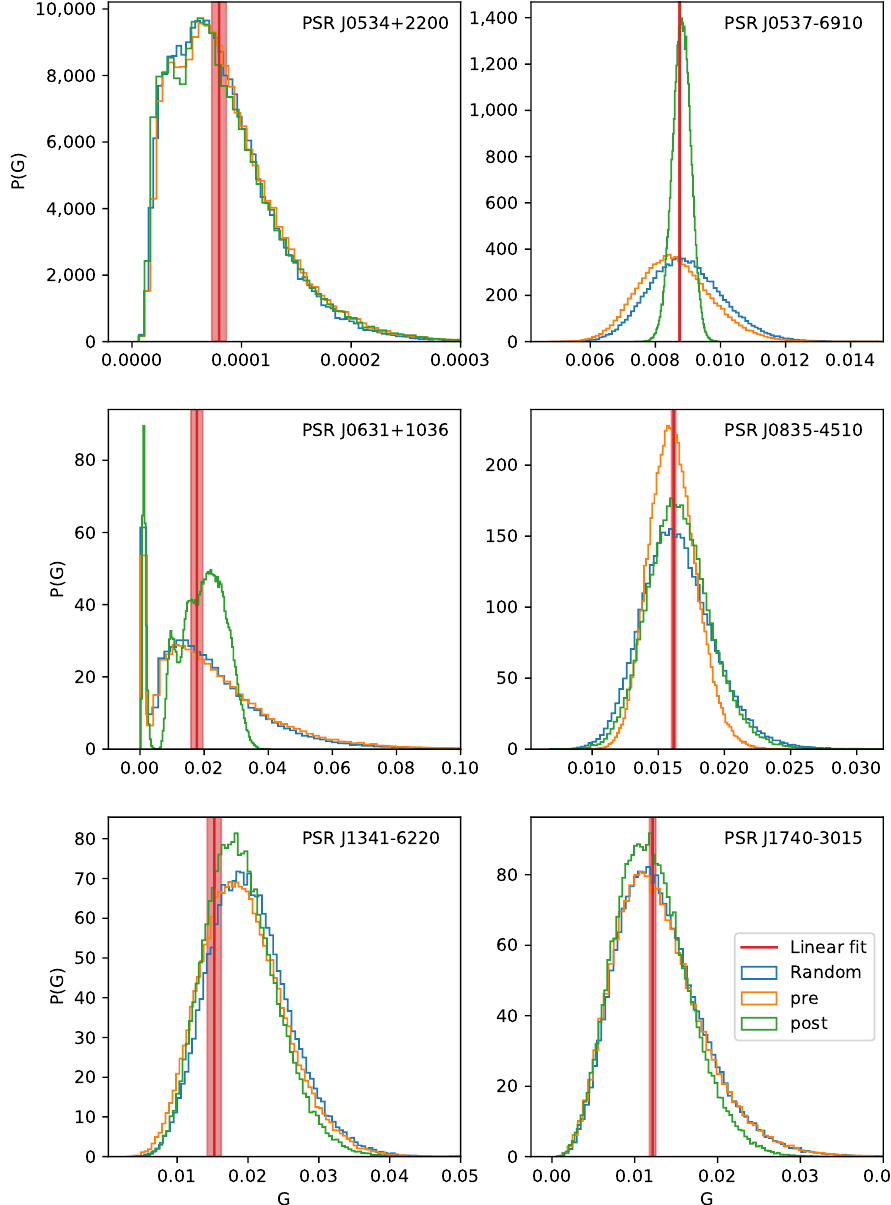
Figure 2. Dimensionless pulsar activity G , calculated by sampling both the size and waiting time samples randomly (in blue), by sampling the pair ( ∆Ω , ∆ t pre ) (in orange) and the pair ( ∆Ω , ∆ t post ) (in green). The results of the linear fit of the cumulative glitch data are also plotted (in red; the shaded area is the 1 σ